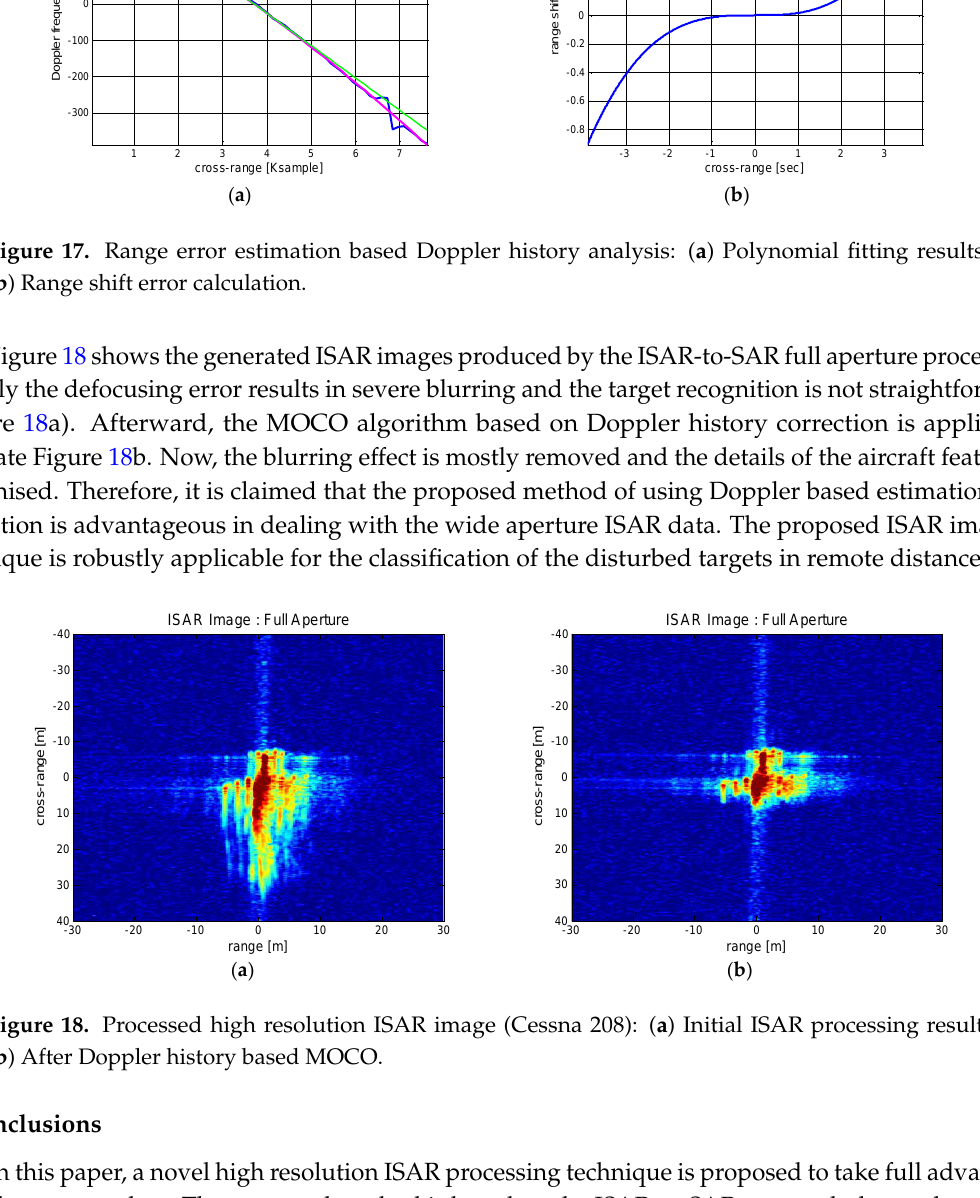
estimation results; ( b ) Motion index estimation; ( c ) Effective velocity estimation.